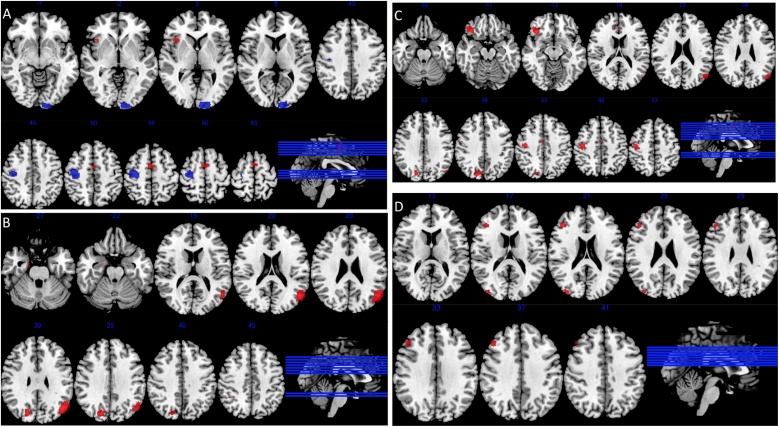
Maps of statistically significant differences in activation (Voxel threshold = p < 0.005, peak height threshold: peak SDM-Z < 1, clusters ≥ 10). Axial brain slice position shown on a sagittal view bottom right, with slices arranged from left to right in the different panels showing brain slices in ascending order from bottom to top.A - Activation of current CU compared to non-using control subjects, increased activation in CU shown in red, decreased activation in CU shown in blue (k = 22; CU n = 361, NU n = 394).B - Activation of adolescent abstinent CU compared to non-using controls, increased activation in CU shown in red (k = 5; CU n = 98, NU n = 106).C - Activation of adolescent abstinent CU compared to current adult and adolescent CU, increased activation in abstinent users shown in red (CCU: k = 22, n = 361; ACU: k = 5, n = 98).D - Adolescent current CU compared to non-using controls, increased activation in CU shown in red (k = 4; CU n = 69, NU n = 70).